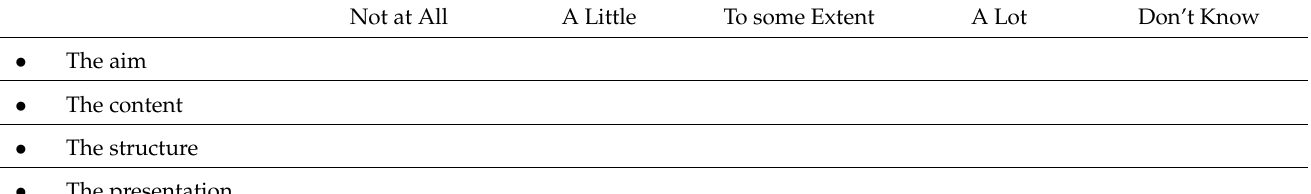
Structure (paragraphs, including paragraph headings) Presentation (how it is written, including argumentation, tenses, etc.) Table A1. Summing up: To what extent did you find the following